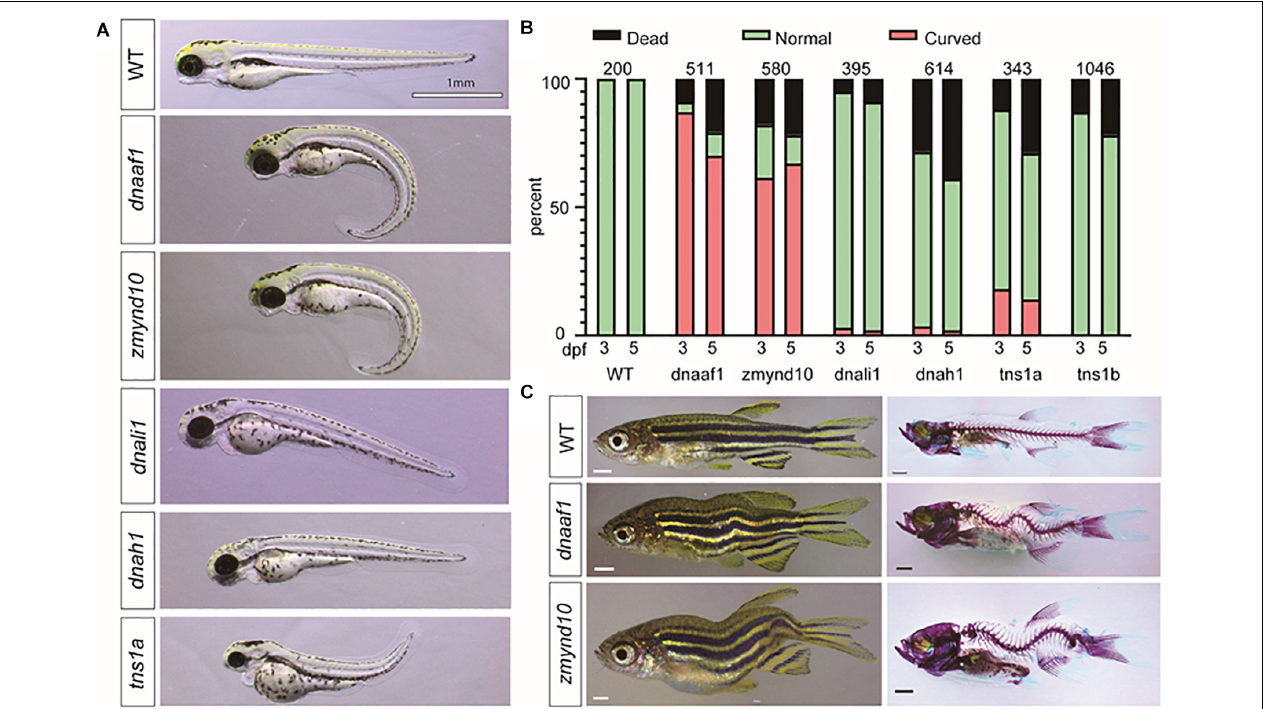
FIGURE 4 | CRISPR/Cas9 knockout of candidate genes in zebrafish recapitulate the scoliosis phenotype. (A) Representative phenotypes of zebrafish larvae 3 dpf (days postfertilization) that were injected with multiplexed CRISPR/Cas9 reagents to target mutagenesis to candidate adolescent idiopathic scoliosis (AIS) associated genes. (B) Histograms representing the total percentage of curve body phenotype assessed at 3 and 5 dpf after injection is shown in the bar graph with red color. The number of larval fish assessed for each targeted gene is displayed in each set of bars. (C) Bright-field images (left) and Alizarin red/Alcian Blue stained (right) zebrafish ( > 30 dpf). All scale bars: 1